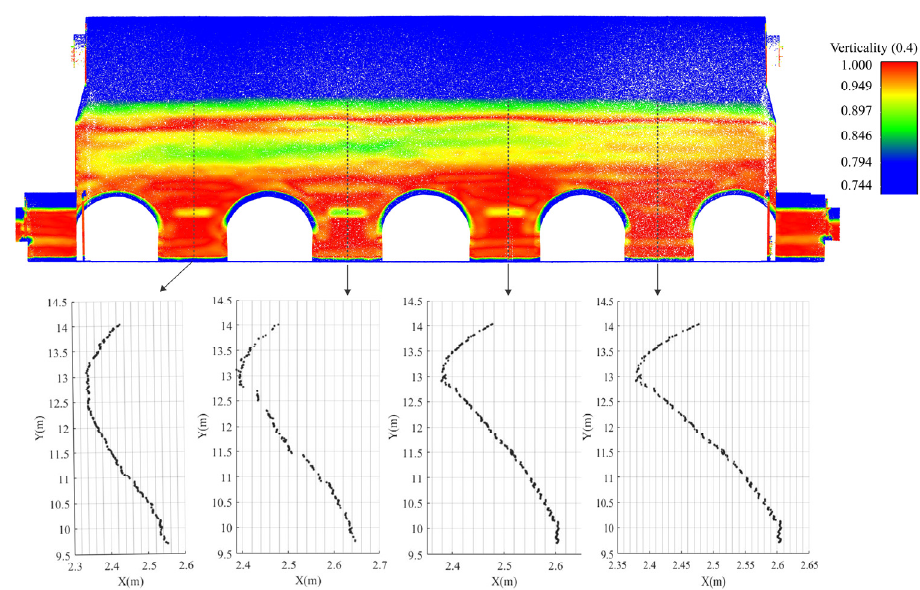
Figure 5. South wall deformation analysis of CA. The top of the image shows the verticality analysis of the wall surface, and the bottom shows the scatter diagram of the local section of the wall.